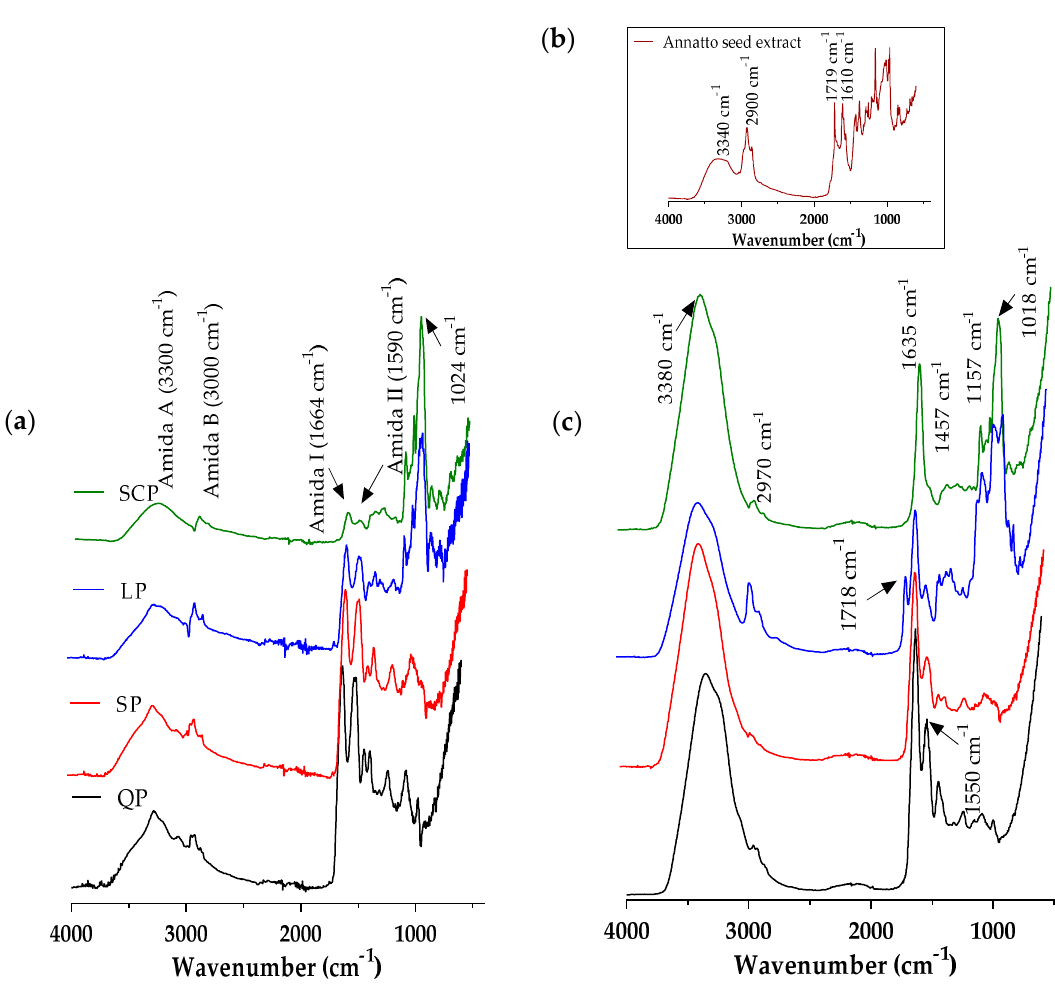
Figure 2. Fourier transform infrared spectroscopy (FT-IR) spectrum average of ( a ) proteins, ( b ) free annatto extract, and ( c )the encapsulated annatto extract with the different carrier materials. LP: lentil protein, QP: quinoa protein, SCP: sodium caseinate, SP: soy protein.